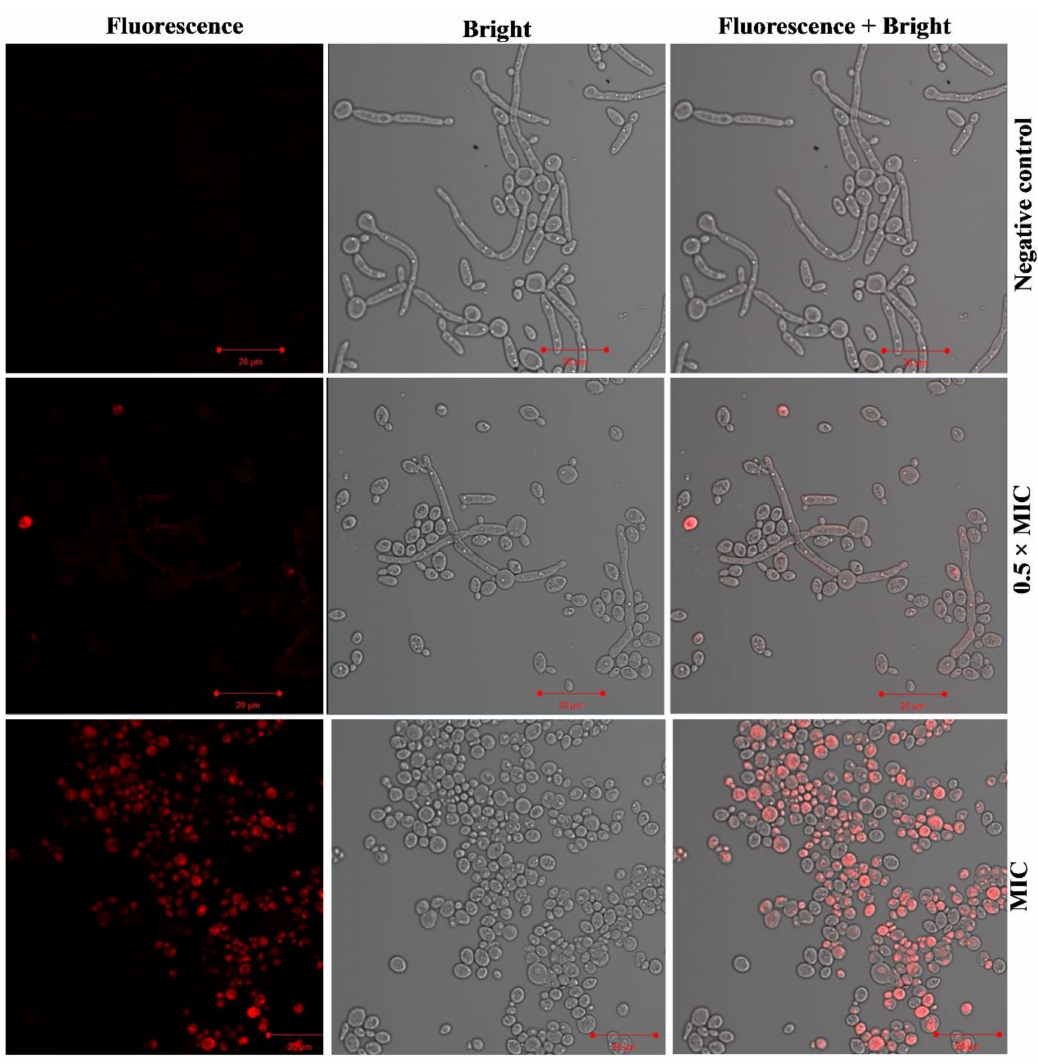
Figure 7. Incorporation of PI by FLZ-resistant C. albicans 5112. The figure shows the membrane disruption ability of Ag-Ni NPs against C. albicans cells. The negative control had cells with intact cell